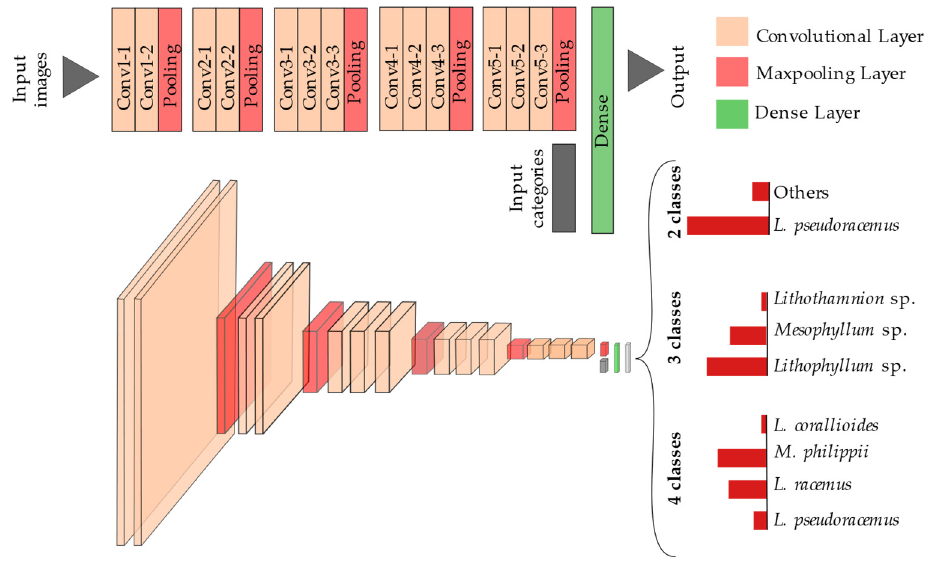
Figure 3. Adapted architecture from Visual Geometry Group 16 (VGG16).